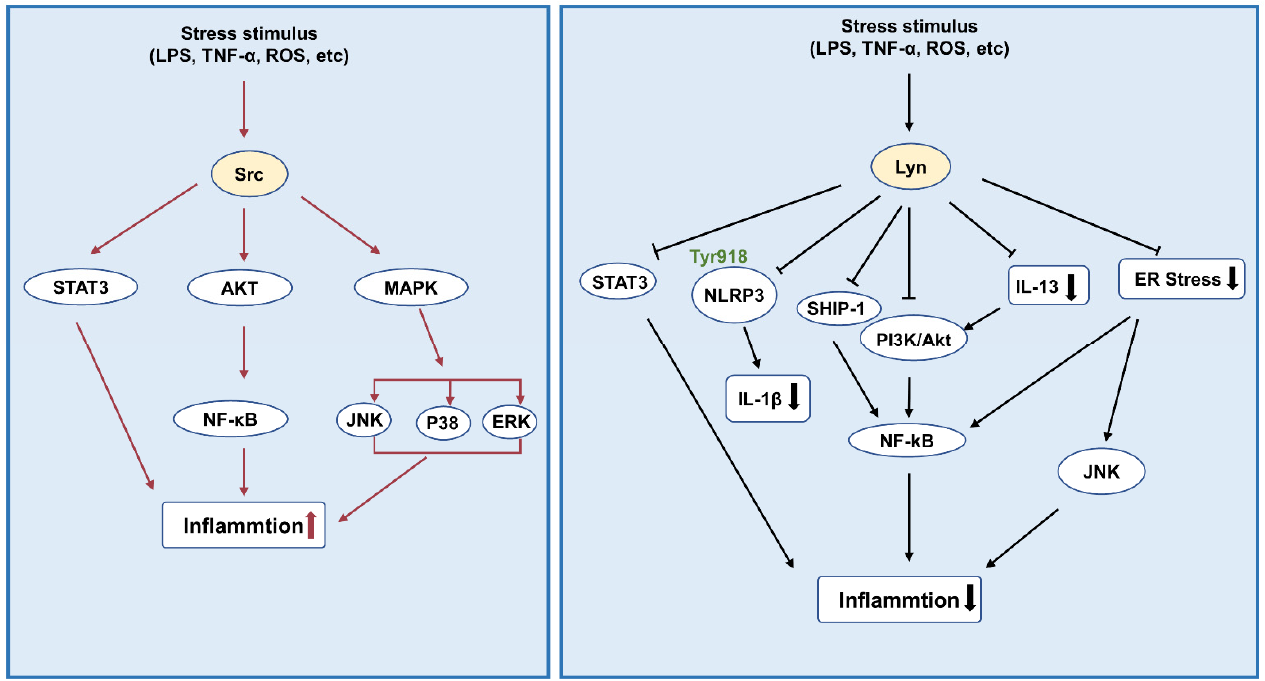
Figure 2. Src family kinases and inflammation. Src activates STAT3, NF- κ B, and MAPK signaling to promote inflammation, while Lyn kinase inhibits the activation of STAT3, NF- κ B, and PI3K/Akt pathways to alleviate inflammation. Abbreviations: ROS: reactive oxygen species; ERK: extracellular signal-regulated kinase; NLRP3: pyrin domain-containing 3 protein; SHP-1: Src homology 2 domain-containing protein tyrosine phosphatase 1; PI3K: phosphatidylinositol 3-kinase; AKT: also known as protein kinase B (PKB).